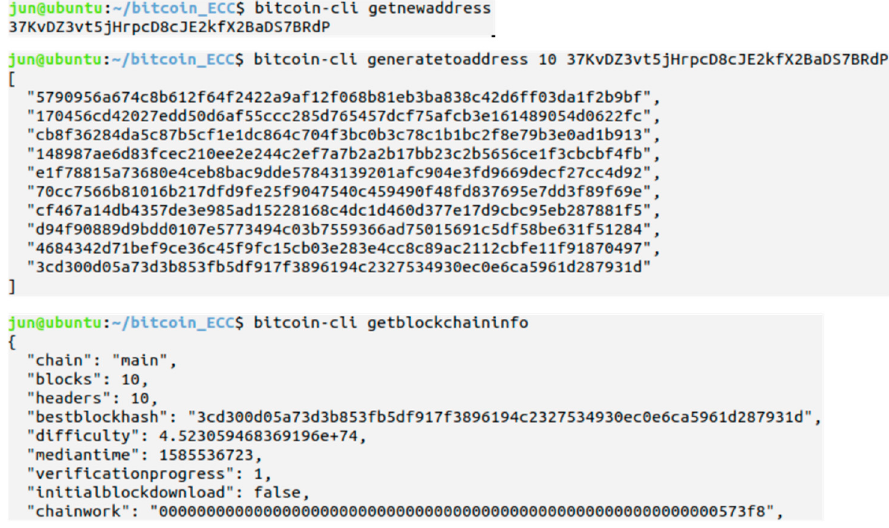
Figure 8. Create account and block in bitcoin.